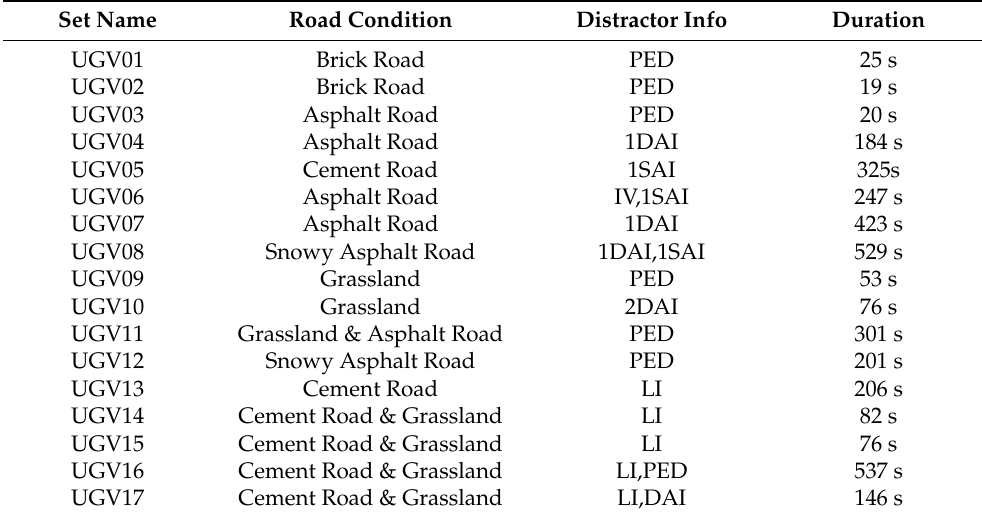
Table 1. Detailed information of the UGV